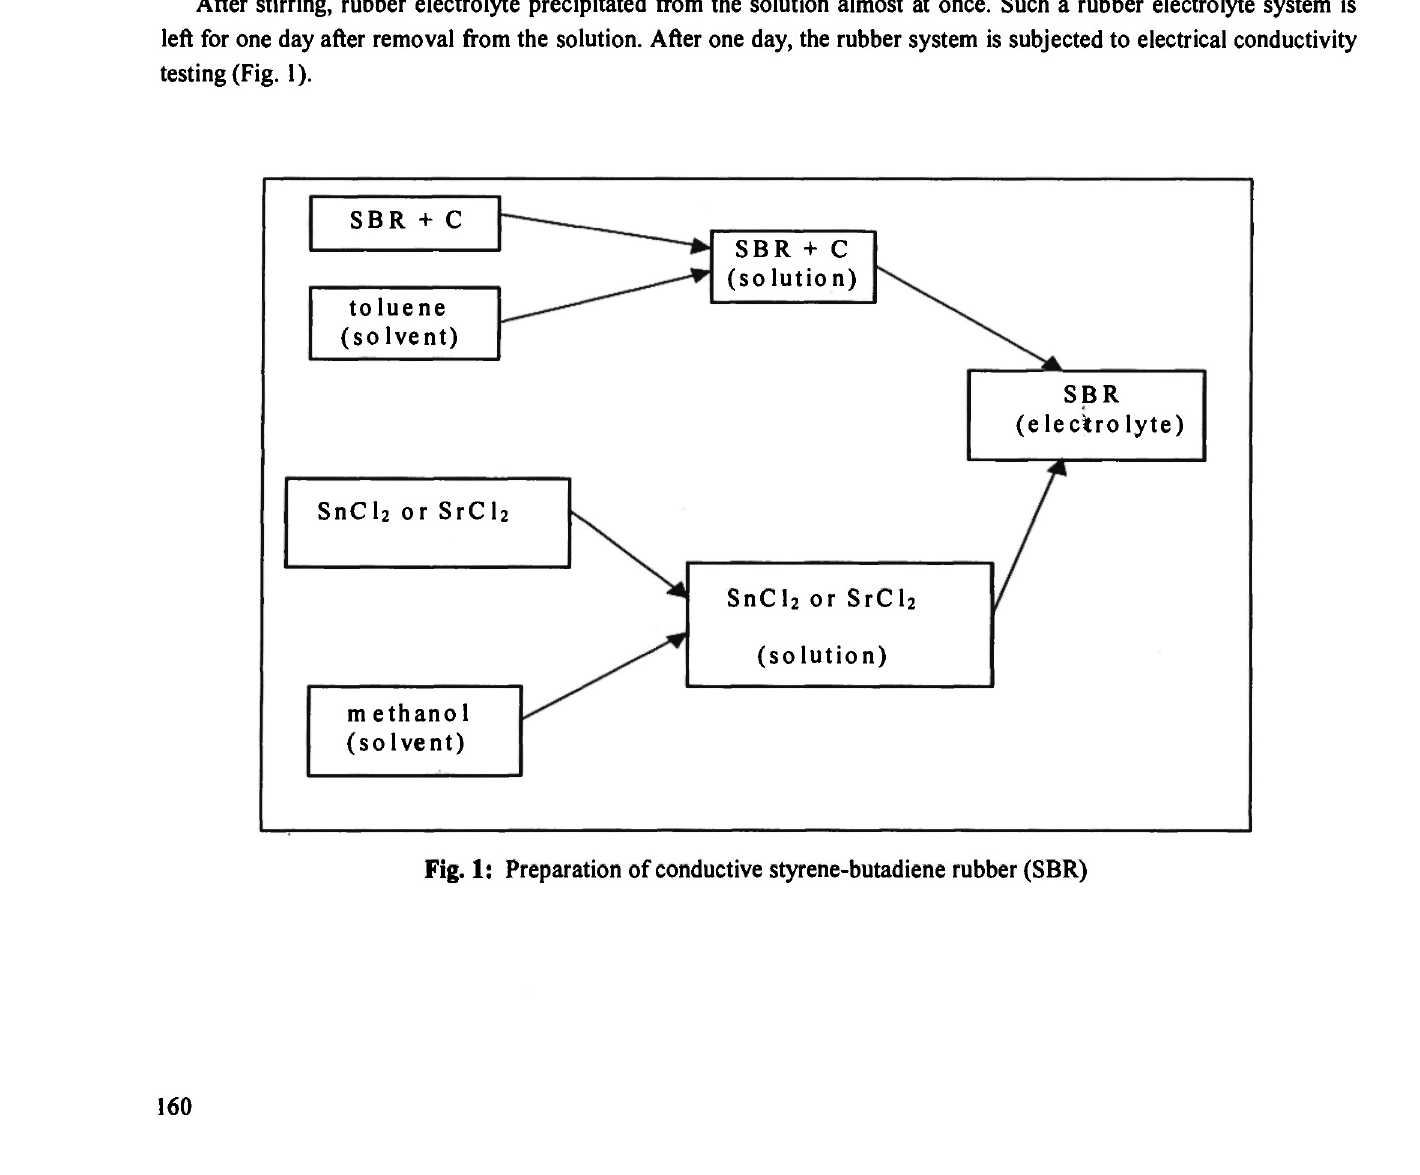
Fig. 1: Preparation of conductive styrene-butadiene rubber